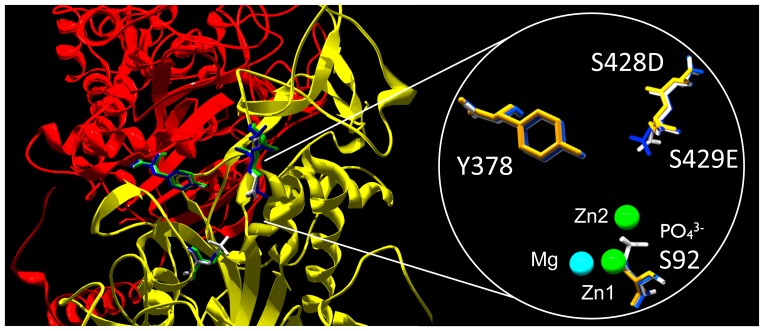
Modeling of the predicted effect of the S429E substitution on the active site environment of the superimposed structures of IAP, PLAP and ChimAP.IAP, PLAP and ChimAP are shown in orange, white and blue, respectively.